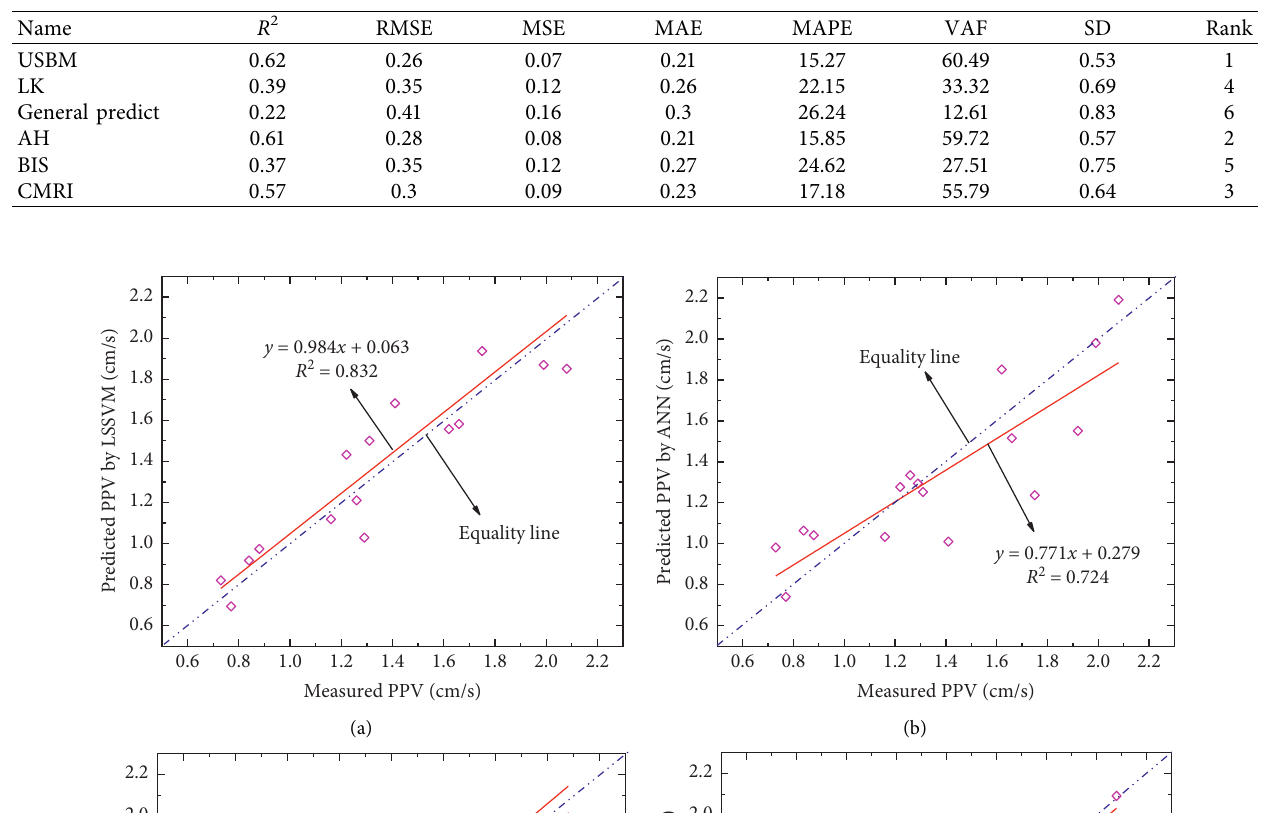
Table 6: Predictive effects of several empirical